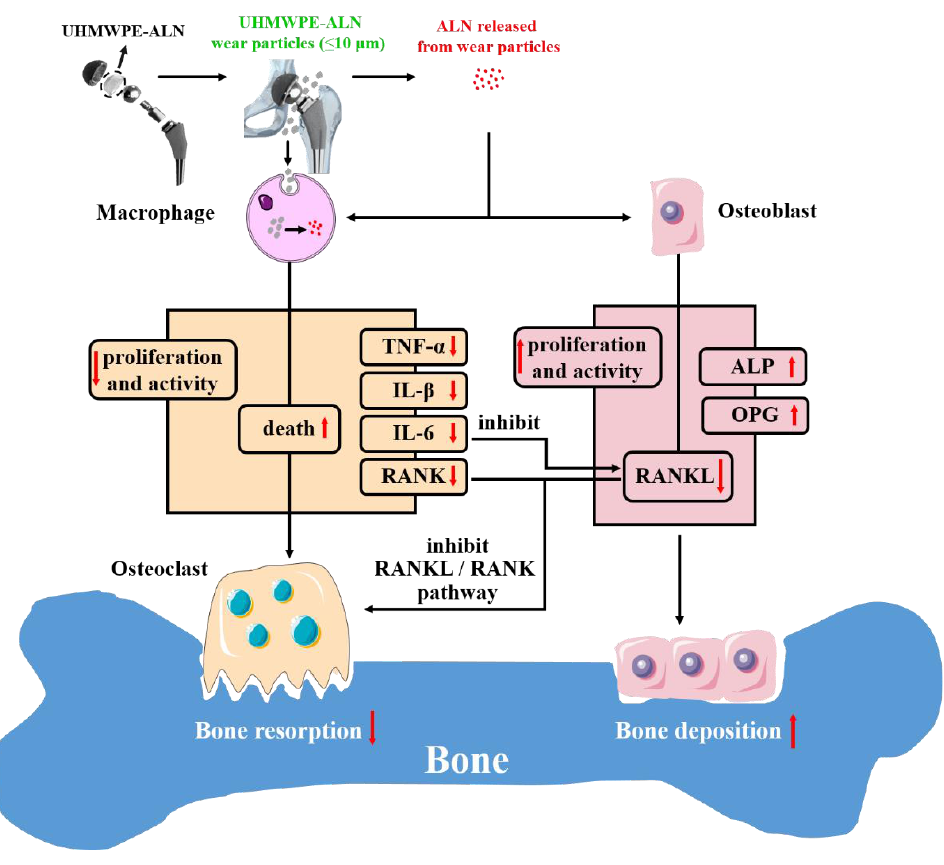
Figure 8. Mechanism of ALN in critical-sized UHMWPE-ALN wear particles to cells and osteolysis. Red upward arrow: increase, red downward arrow: decrease.